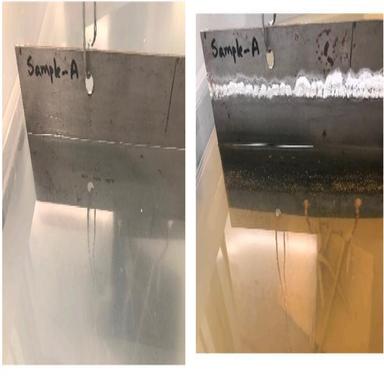
Sample a IN SCC test setup condition; (A) DAY 1, (B) DAY 40.